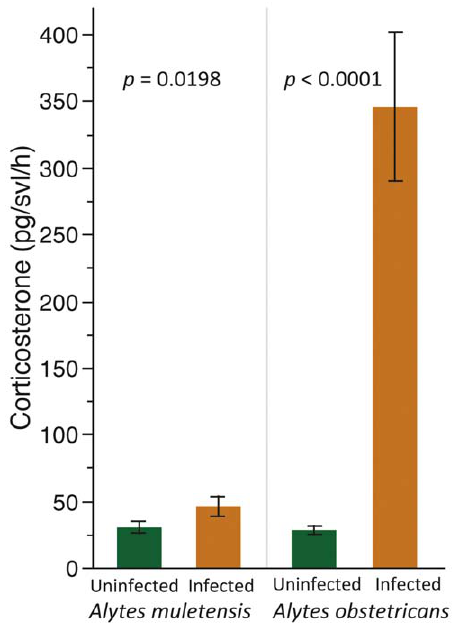
Figure 1. Mean corticosterone release rates. The mean cortico- sterone (pg/svl/h) 6 S.E. of infected vs uninfected populations of Alytes obstetricans and A . muletensis .